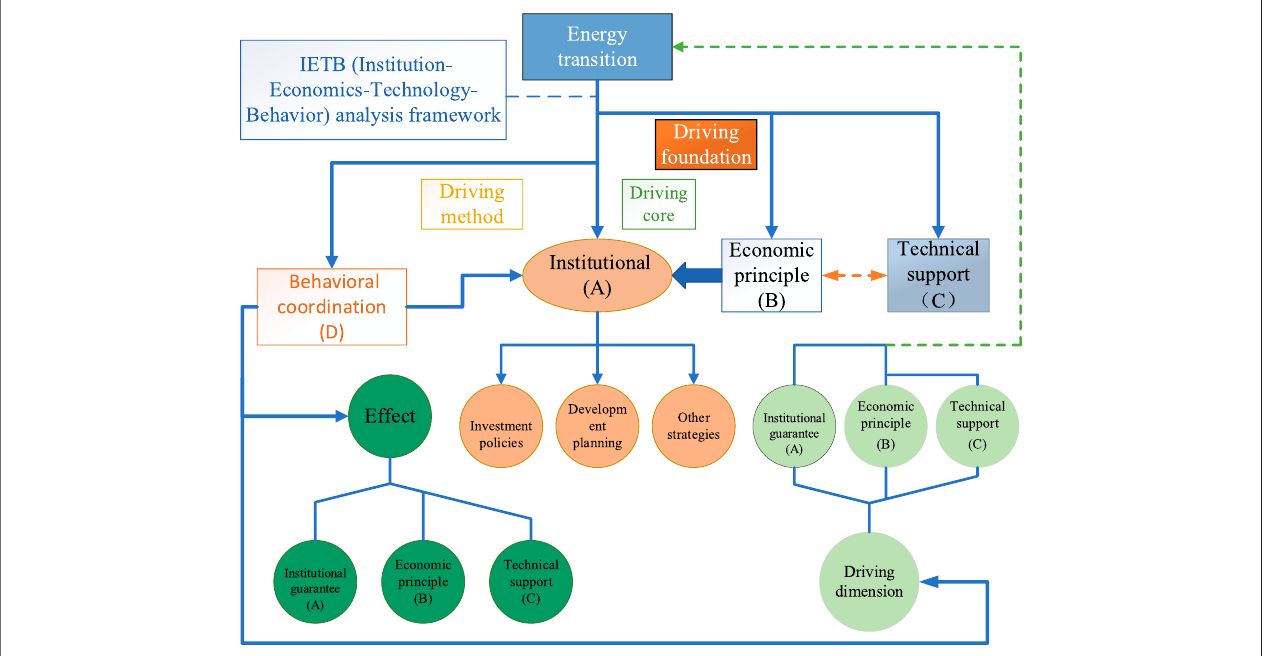
FIGURE 2 | IETB conceptual analysis